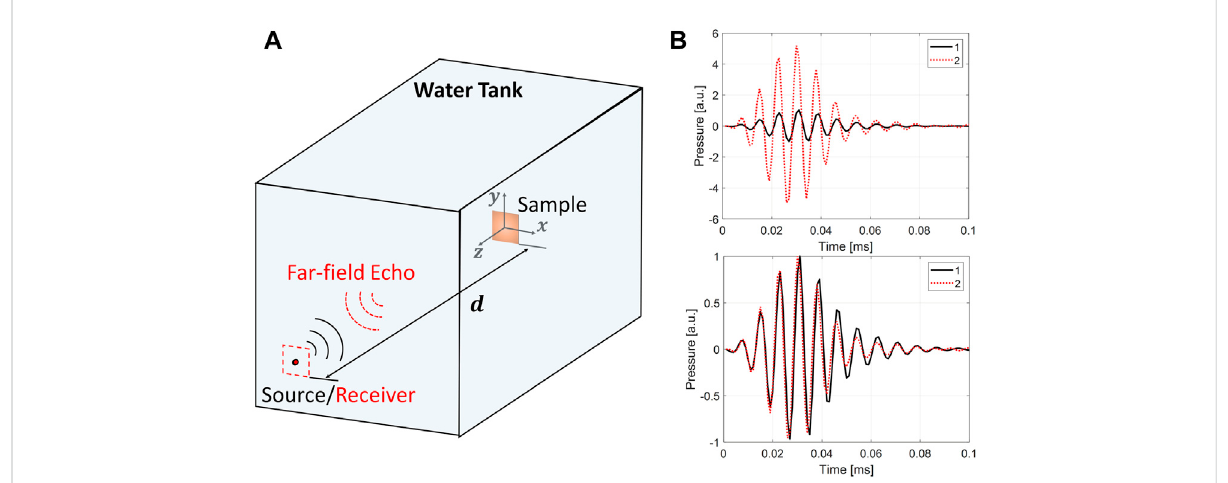
FIGURE 1 Schematic of material characterization using far- fi eld acoustic echoes. (A) A small sample of known geometry and unknown material parametersisensoni fi edbyapointsourceandechoesaremeasuredbyareceiverco-locatedwiththesource. (B) Far- fi eldechoesfromtwodifferent materials show complex time domain variation. The top and bottom panels show echoes before and after normalization. The change in material parameters result in echo amplitude and shape